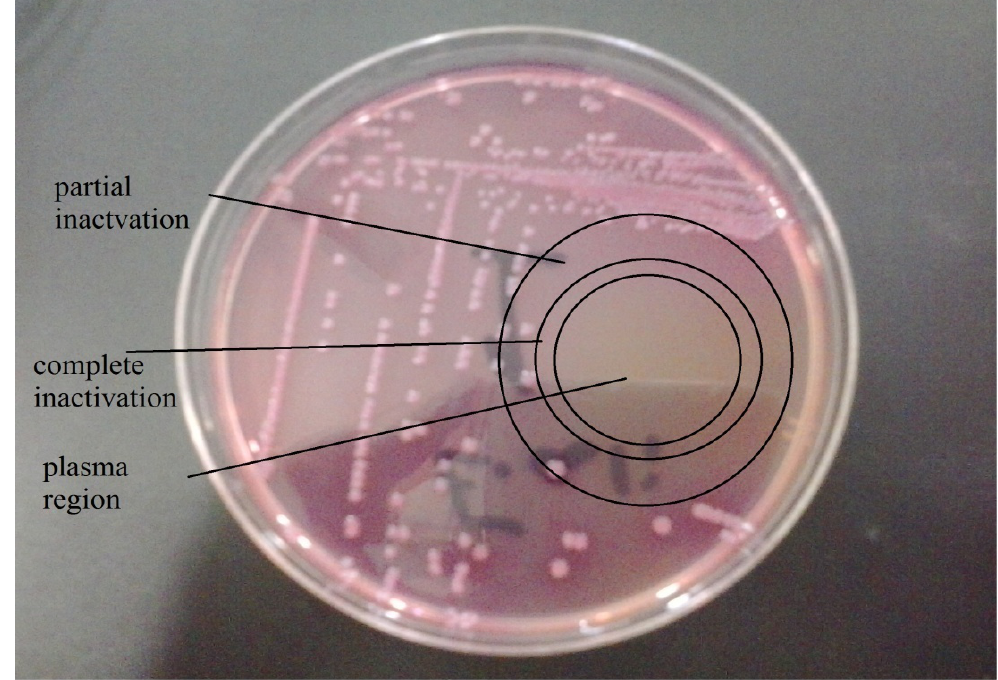
Fig.2: Petri dish with MacConkey agar after the DBD plasma